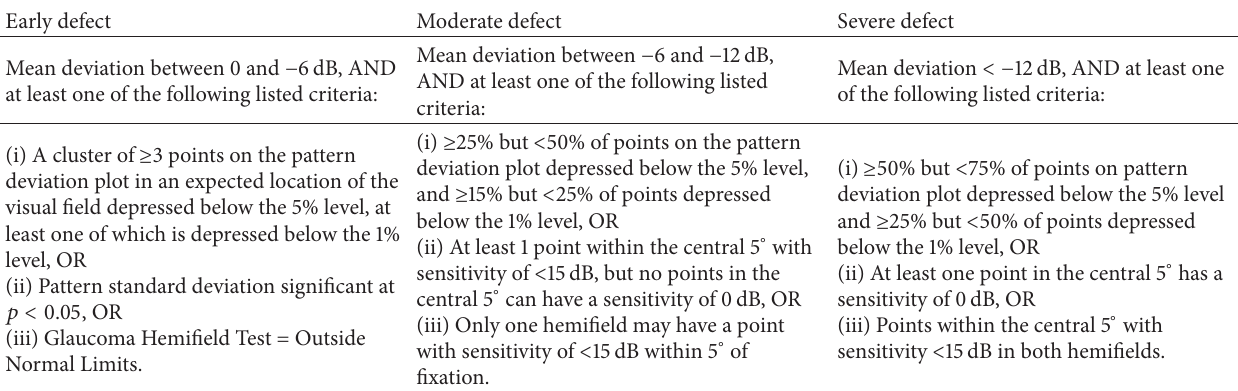
Table 1: Hodapp-Parrish-Anderson classification